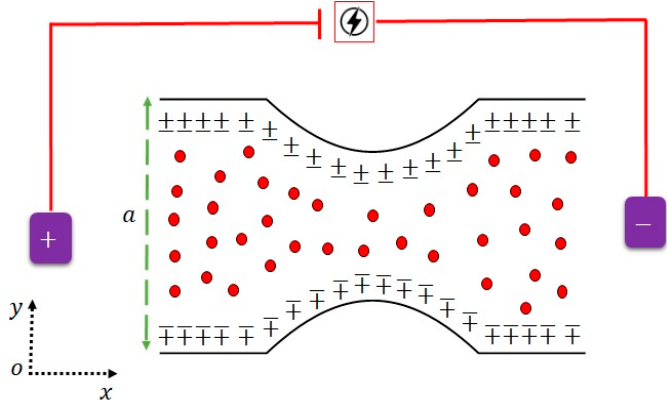
Figure 2. Divergent geometry. 2.1. Flow Equations for Fluid Phase The equation of continuity which governs the conservation of mass of the fl ow is .